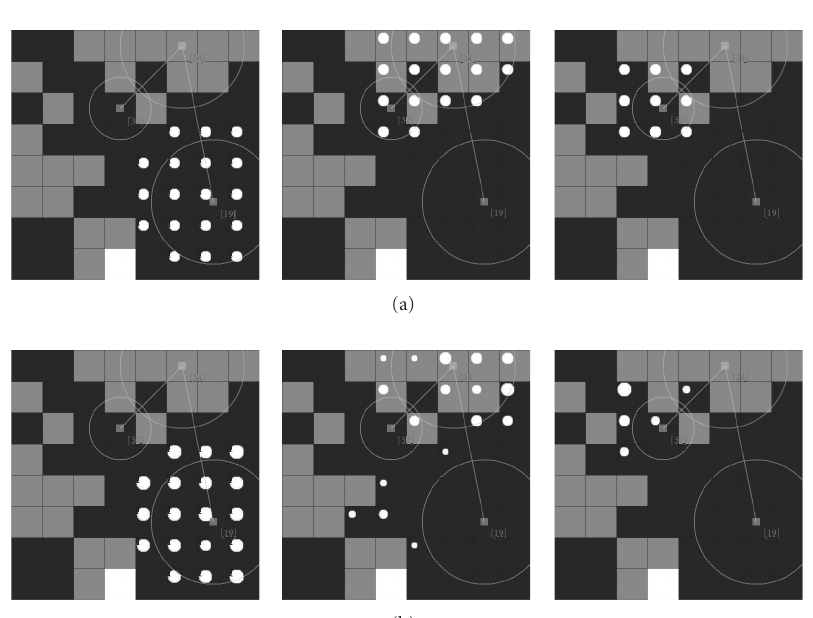
Figure 8: Test result.